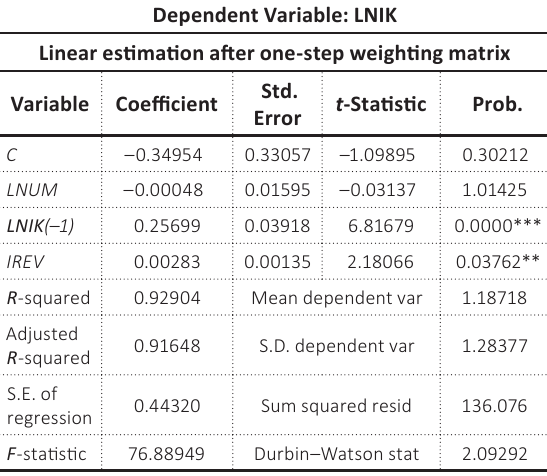
Table 3. Effect of irreversibility on